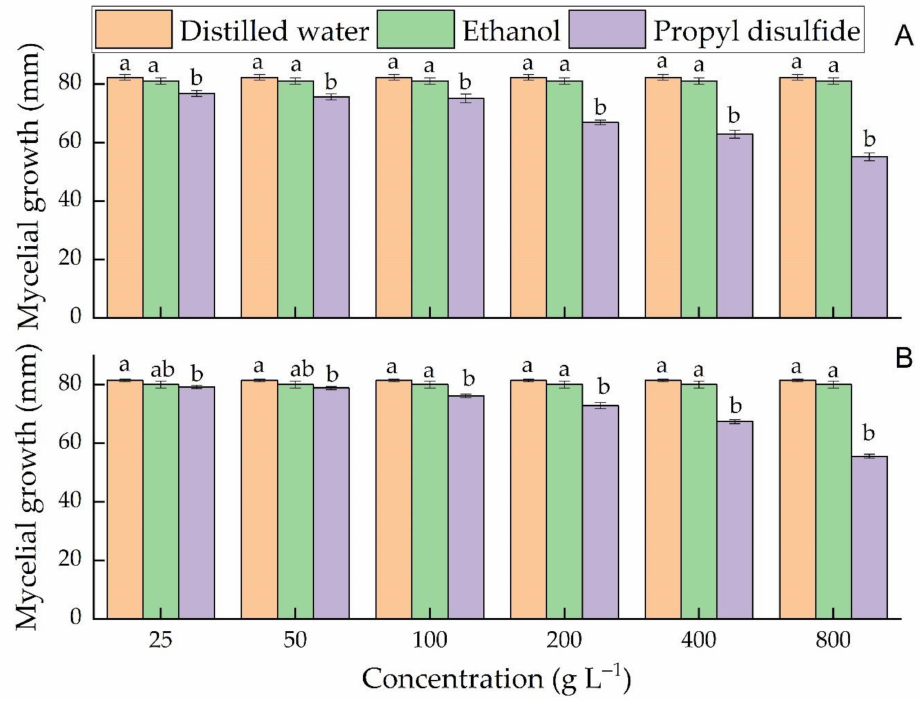
Figure 4. Effects of different concentrations of propyl disulfide in the agar diffusion assay on the mycelial growth of C. acutatum at day 14 ( A ) and C. gloeosporioides at day 10 ( B ). Different small letters in each concentration represent a significant difference among the treatments. The mycelial growth presented is the mean of five replicates ± SD at p ≤